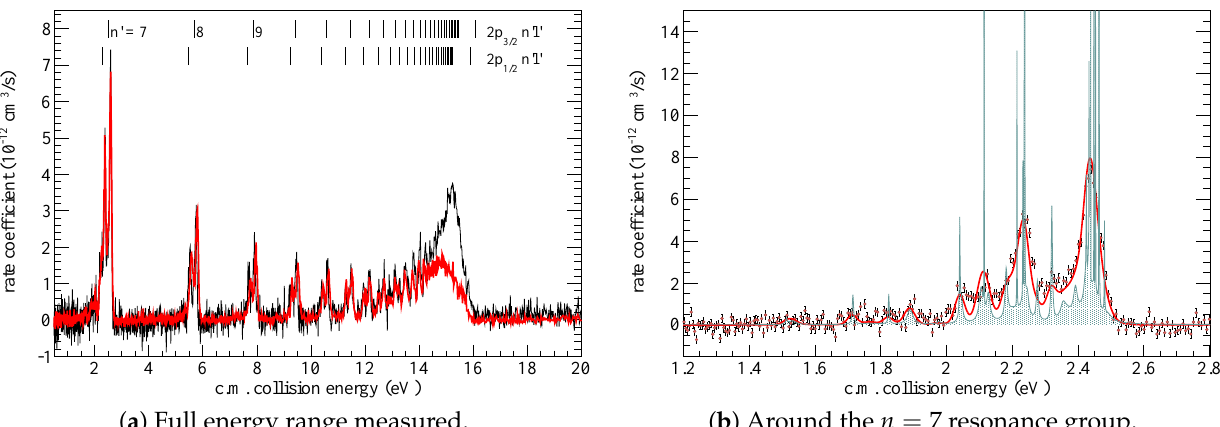
Figure 6. Merged-beams recombination rate coefficient for DR of Ne 7 + + e − → Ne 6 + . The vertical lines at the top of the graph indicate the positions of Rydberg levels populated by the dielectronic capture. Panel ( a ) shows our new data (black line) with the previous results from Stockholm (red line) [23] for the same species. Panel ( b ) shows our data in comparison with theoretical data [24]: A theoretical merged-beam rate coefficient, convolved with the electron temperatures for our cooler setting is shown as a red line, its underlying cross section in natural line widths is indicated by the teal filled area. Please see the main text for details. The final analysis will be given in